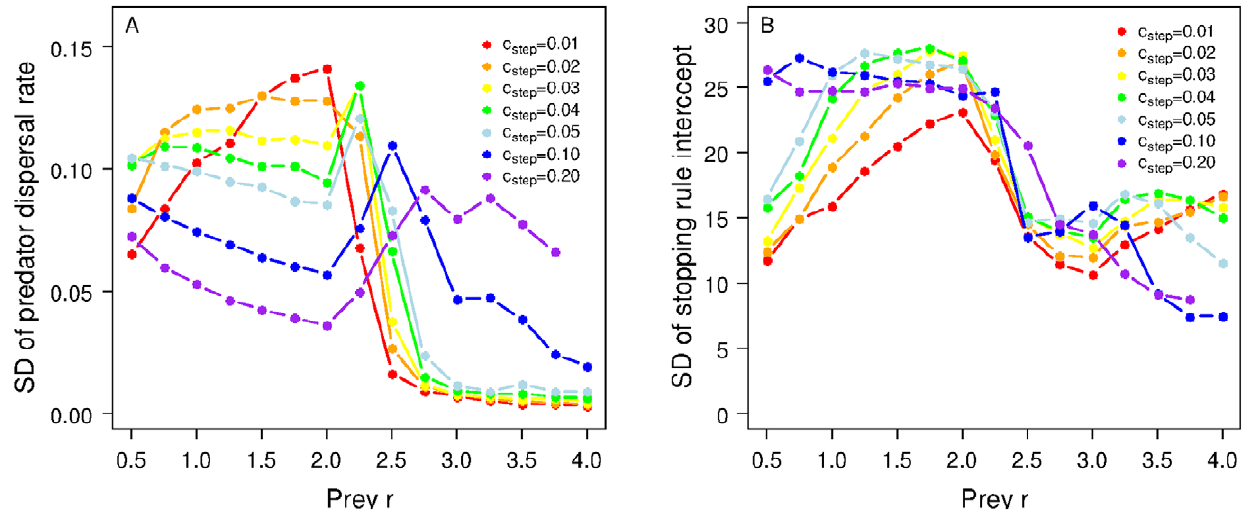
Figure 4. Within-population variability in dispersal rules depends upon spatio-temporal prey dynamics. As well as determining the mean dispersal rules, the underlying prey dynamics influence the emergent heterogeneity in dispersal rules. (A) The standard deviation in the emigration probability across a range of prey r . (B) The standard deviation in the intercept of the reaction norm that determines the stopping probability as a function of prey per predator. All parameters values are as for Fig 3. Note that where there are missing values it is due to the predator populations always going to extinction; this occurs when prey r and c step are both high.